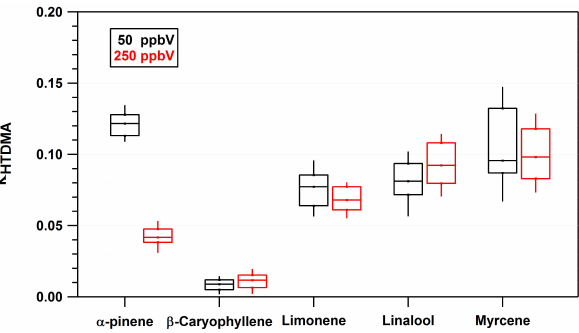
Fig. 5. A box and whisker plot illustrating the observed range of hy- groscopic properties, represented by κ HTDMA , for all selected dry particle diameters for particles generated from each initial mixing ratio of the studied precursors. Fig. 6. Temporal profiles of hygroscopic growth factors at 90% RH